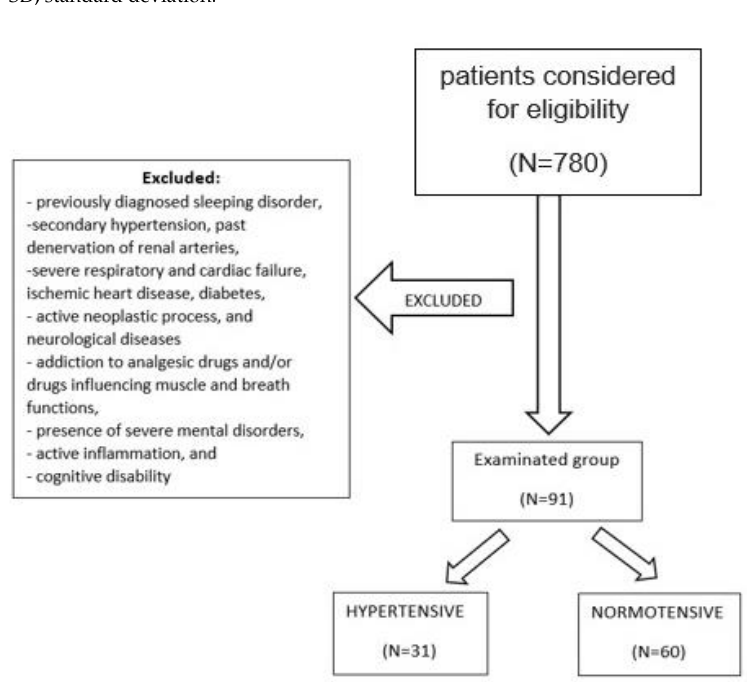
Figure 1. Flowchart. Figure 1.